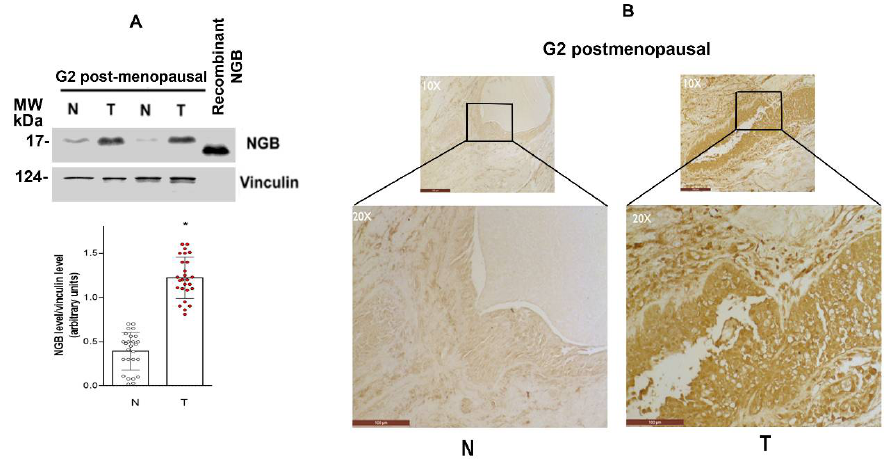
Figure 1. NGB levels in breast cancer tissue. Representative Western blot images of NGB protein levels ( A ) in two G2- grade post-menopausal specimens of breast cancer (T) and their normal counterpart (N). The amount of protein was normalized by comparison with vinculin levels. A total of 5 ng of recombinant NGB was used as protein standard. Data are the mean ± SD of 26 tissues. * p < 0.001 was calculated with Student’s t-test with respect to normal tissues. ( B ) Representative immunohistochemical staining of NGB (mouse monoclonal Clone 6G1.1 anti-NGB MERCK) in 1 out of 10 breast G2-grade post-menopausal specimens of breast cancer (T) and normal counterpart (N). The scale bar is 100 μm/cm. The black square refers to the below-reported optical magnification.